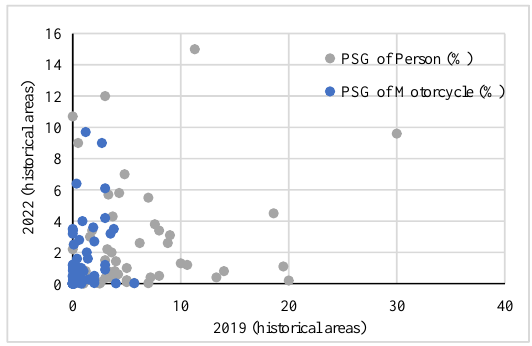
Figure 9. PSG of person and motorcycle. Figure 10. PSG of person and motorcycle in historical Figure 10. PSG of person and motorcycle in historical areas.